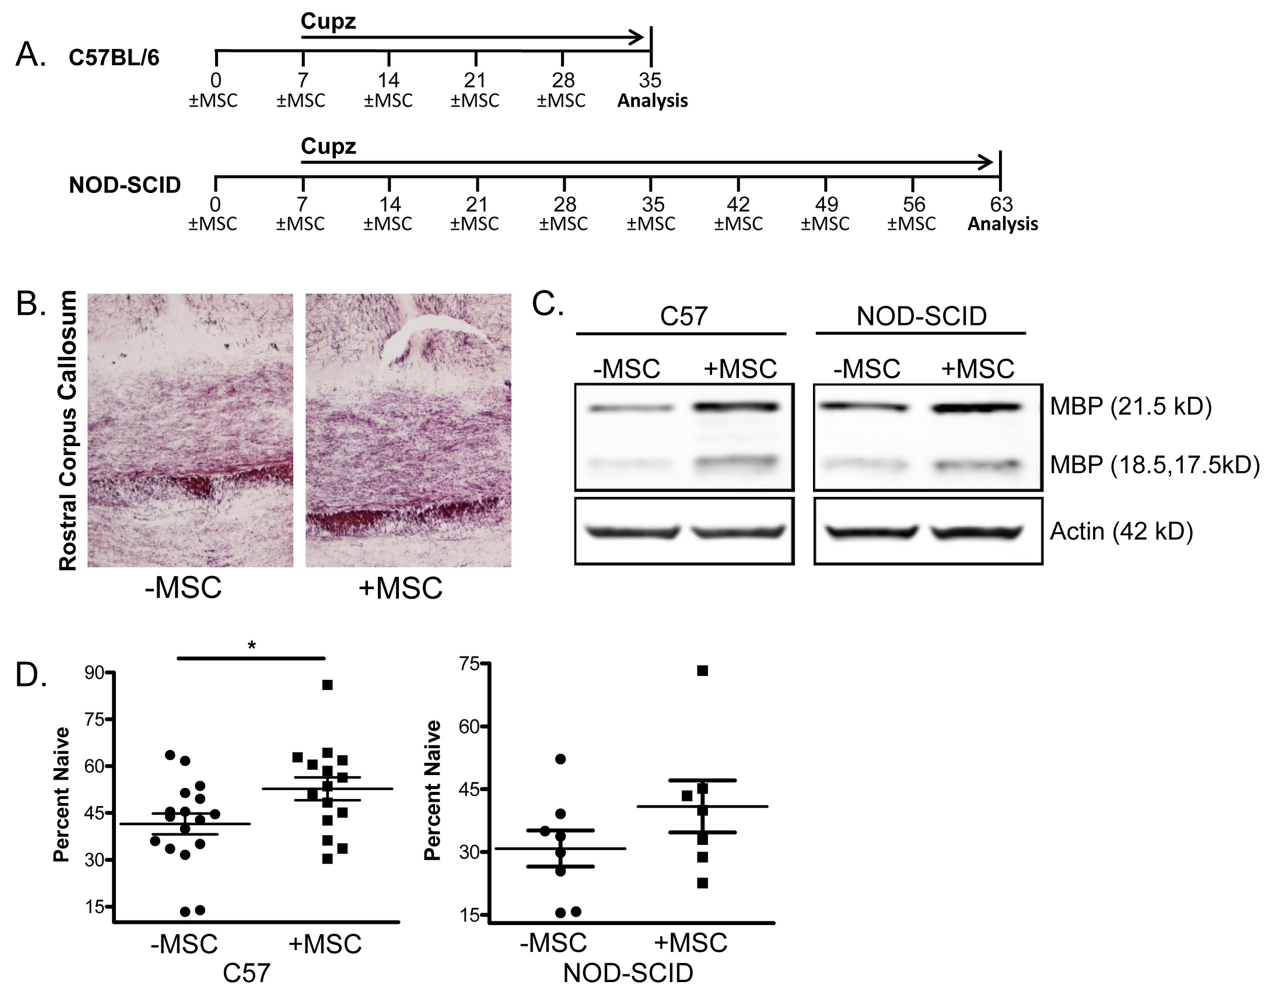
Fig 4. MSCs modestly suppress demyelination in cuprizone-treated mice. (A) C57BL/6 (C57) or NOD-SCID (N-S) mice were fed cuprizone (Cupz, 0.2 w/w)-containing rodent diet continuously for either 4 (C57) or 8 (N-S) weeks, concomitant with weekly i.p. injections of either MSCs or PBS vehicle, which were typically initiated one week prior to cuprizone feed. Mice were then euthanized for downstream brain myelination analyses. MSC administration resulted in higher quantities of myelin, as evidenced by Black Gold staining (C57 rostral corpus callosum (CC) shown in B) and by Western blot probing of MBP large (21.5 kD) and small (18.5 and 17.5 kD) isoforms in C57 CC and N-S hippocampus(Hp) (C) . Quantitative myelin measurements from either C57 or N-S- derived combined large and small MBP isoforms were generated from Western blot densitometries (D) . Each graph shows the combined results from two individual experiments (n = 15 – 17 C57and 7 – 8, (N-S). Significance was measured by Student ’ s t -test, with * p <